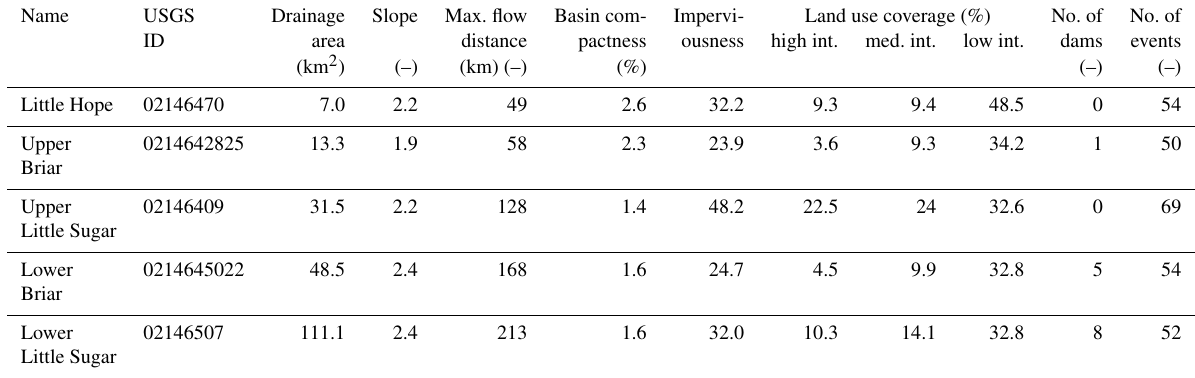
Table 1. Summary of hydrological basins in the Little Sugar Creek catchment: basin area (km 2 ), imperviousness (%), slope (–), land use coverage (high intensity, medium intensity, low intensity urban development) (%), maximum flow distance (km), number of dams regulating stormwater flows (–), number of POT flood events used for analysis